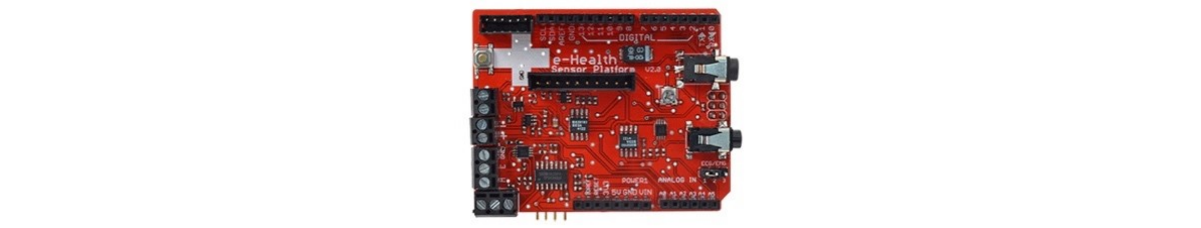
Figure 5. eHealth Sensor Shield.